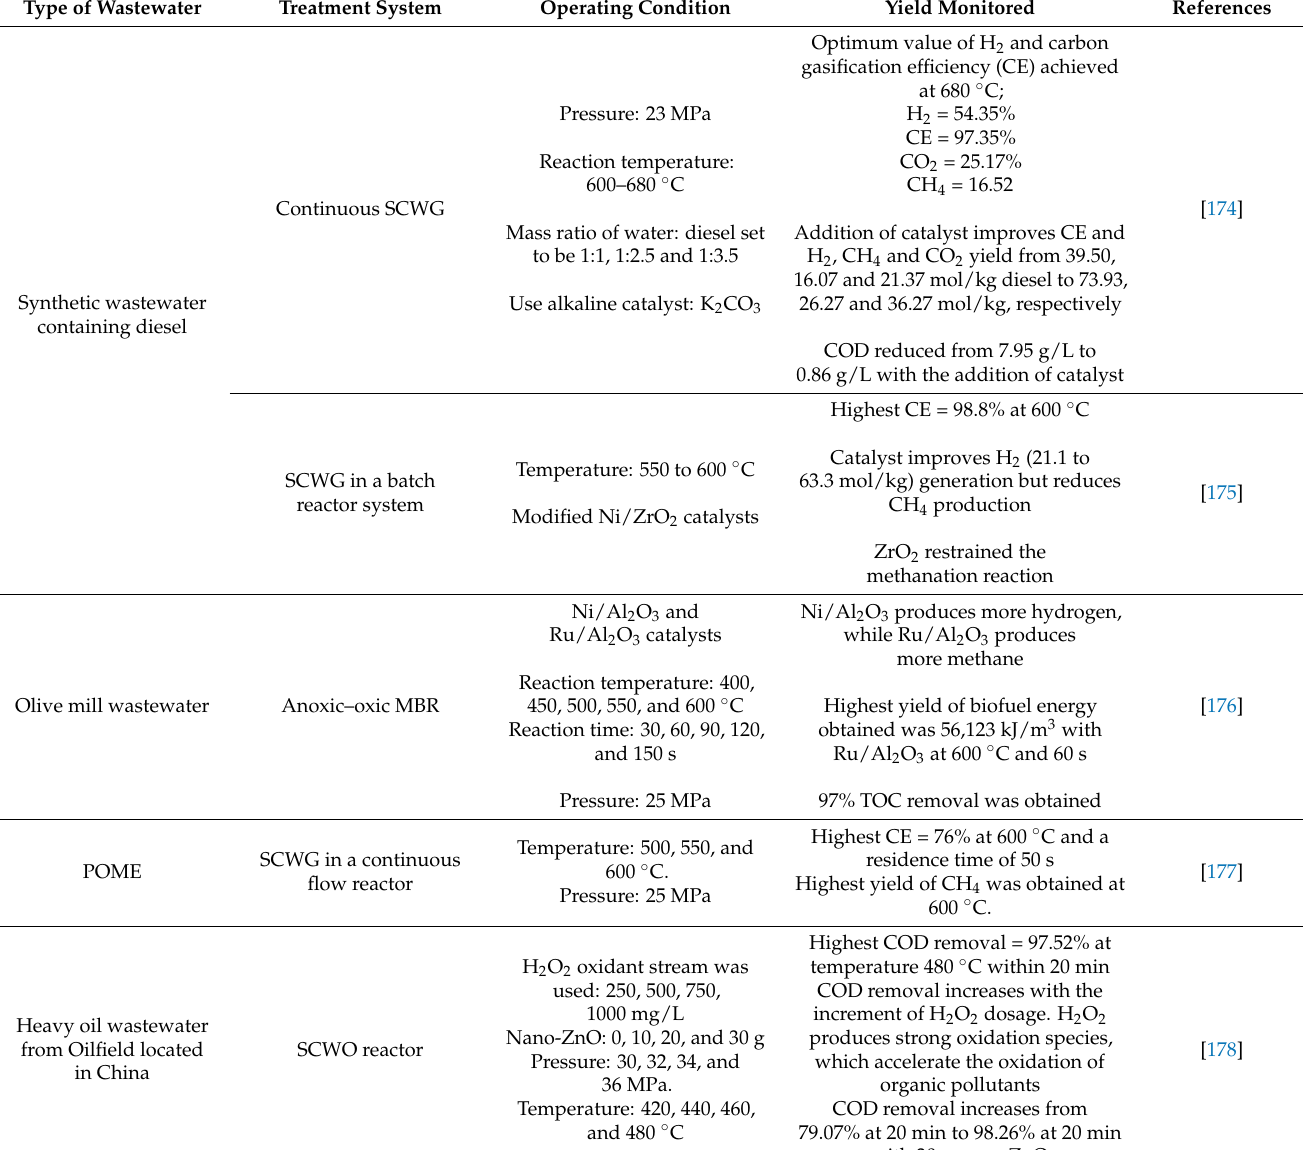
Table 7. Research on the effects of operating conditions on the performances of supercritical water oxidation (SCWO) and supercritical water gasification (SCWG) from 2018 to